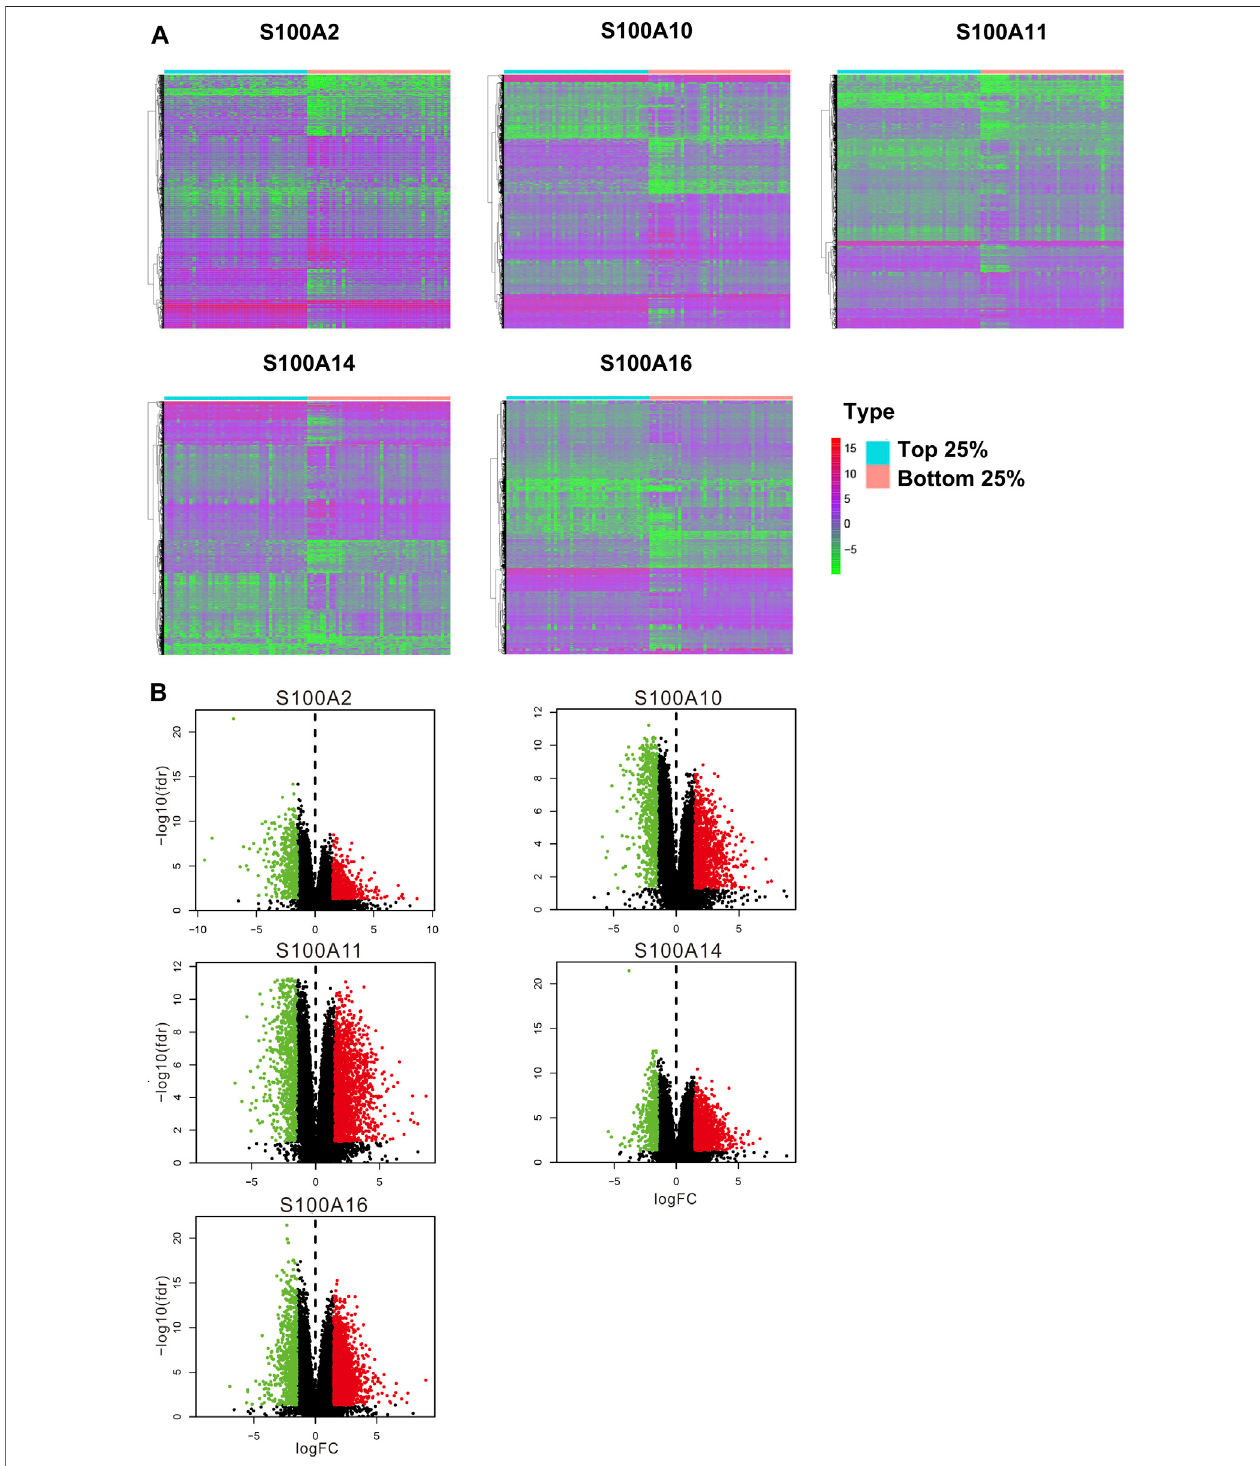
FIGURE 10 | Differential expression analysis of samples with high expression of the signi fi cant S100 genes (top 25%) vs low expression (bottom 25%) samples (calculated data form TCGA-PAAD database, n (cid:1) 178). (A) Differentially expressed genes were displayed by heatmap. Wilcox test was used to analyze differentially expressed genes. The screening conditions are FDR (cid:1) 0.05 and logFC (cid:1) 1.5. The green on the heatmap indicates low expression and red indicates high expression. (B) Volcano plot. The green dot on the volcano plot represents down-regulated expression, and the red dot represents up-regulated expression.